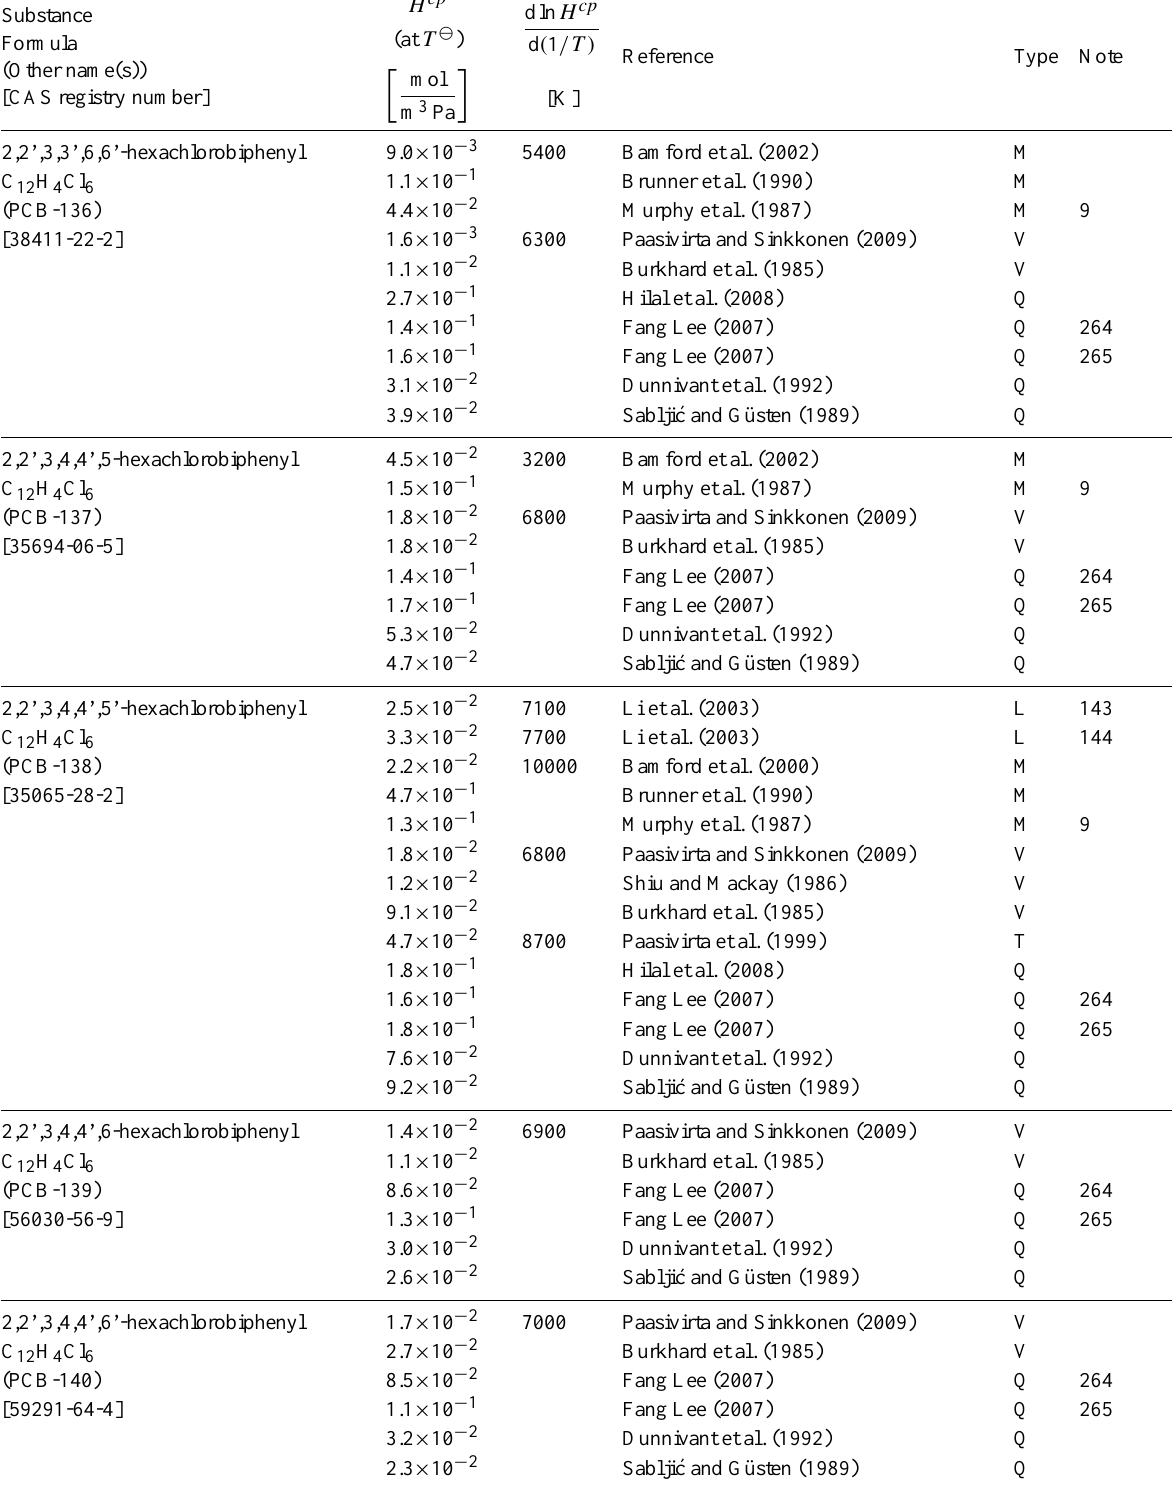
Table 6: Henry’s law constants for water as solvent